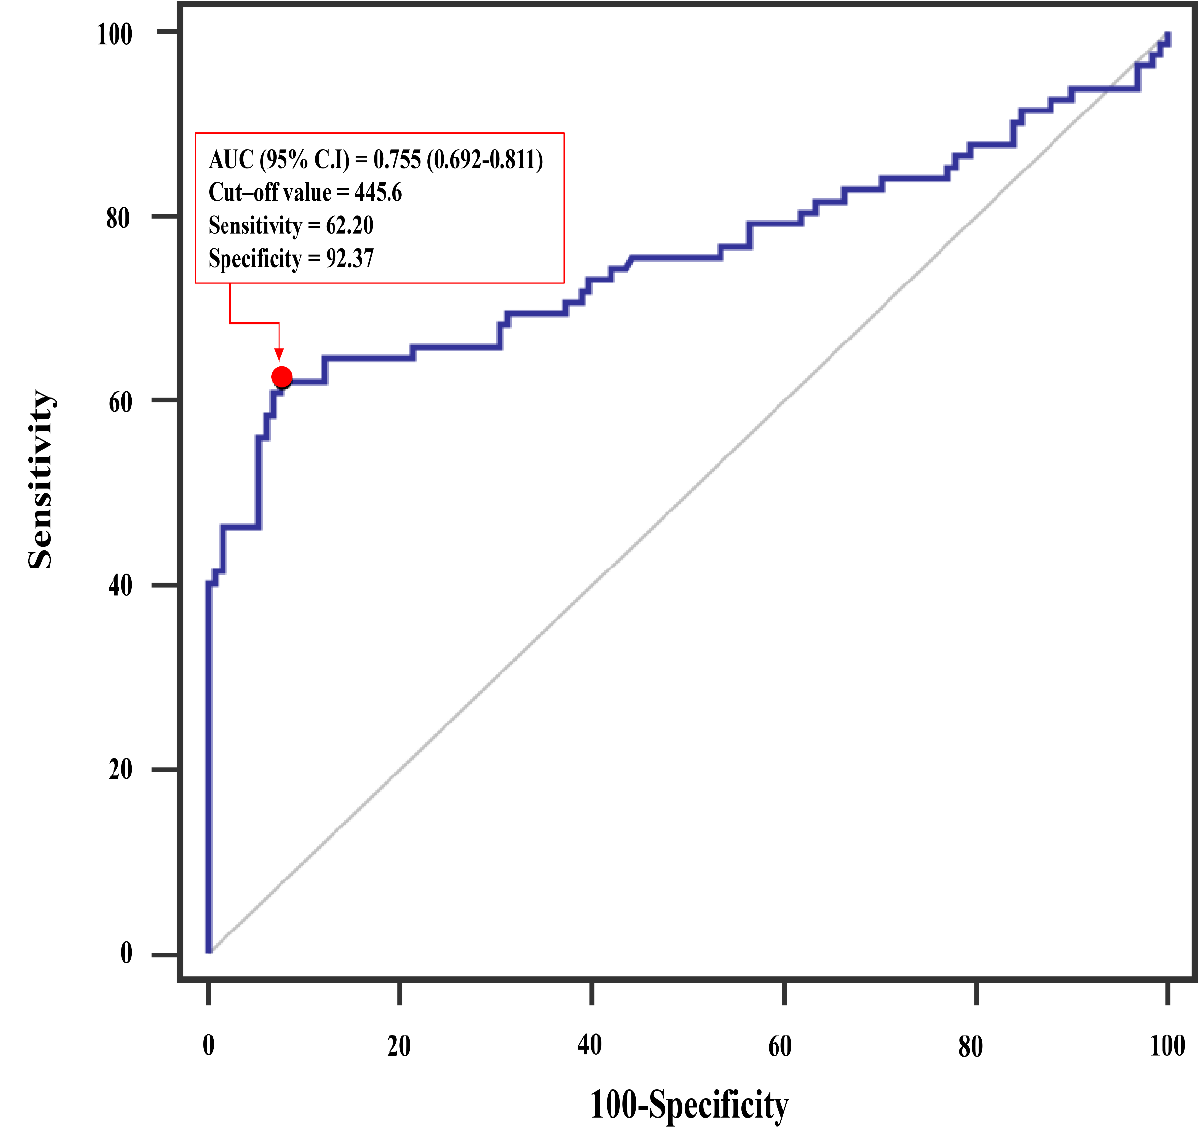
Figure 2. Receiver operating characteristics (ROC) analysis showing the prediction of major postoperative complication via systemic immune-inflammation index after isolated tricuspid valve surgery. AUC, area under the curve; CI, confidence interval.